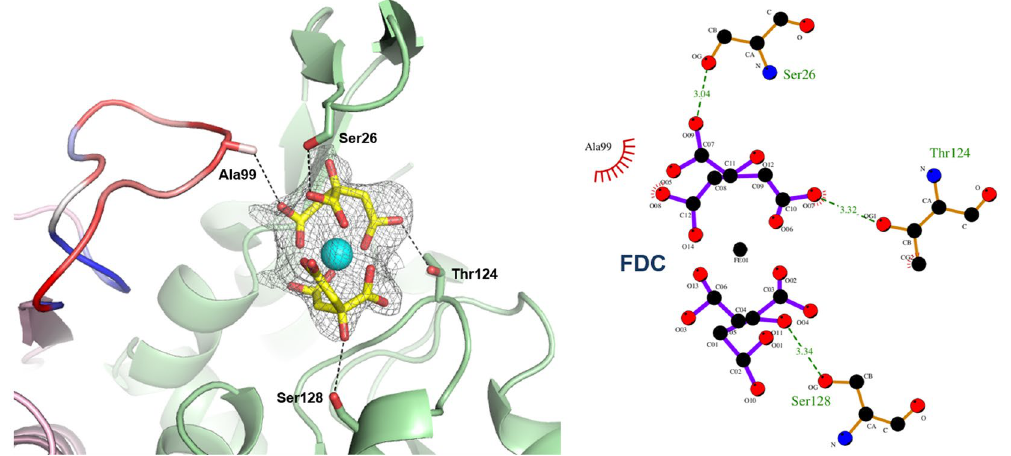
Figure 4. M. tuberculosis OPRTase active site in complex with FDC. Left: calculated unbiased omit map. The flexible loop is coloured according to B-factors values in a blue-white-red scale (from low to high values). Interactions between ligand and active site residues are shown as dashed black lines. Right: interaction diagram showing the residues involved in FDC binding. Distances are expressed in Ångstroms.